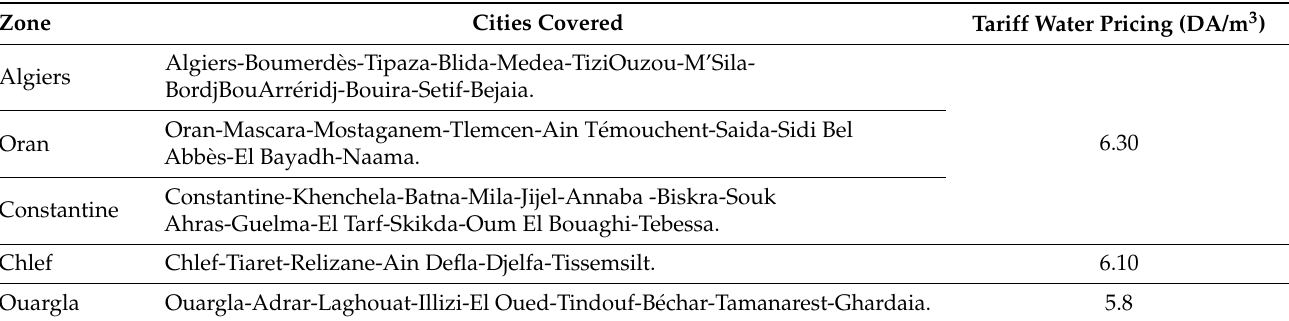
Table 9. Tariff water pricing for the five